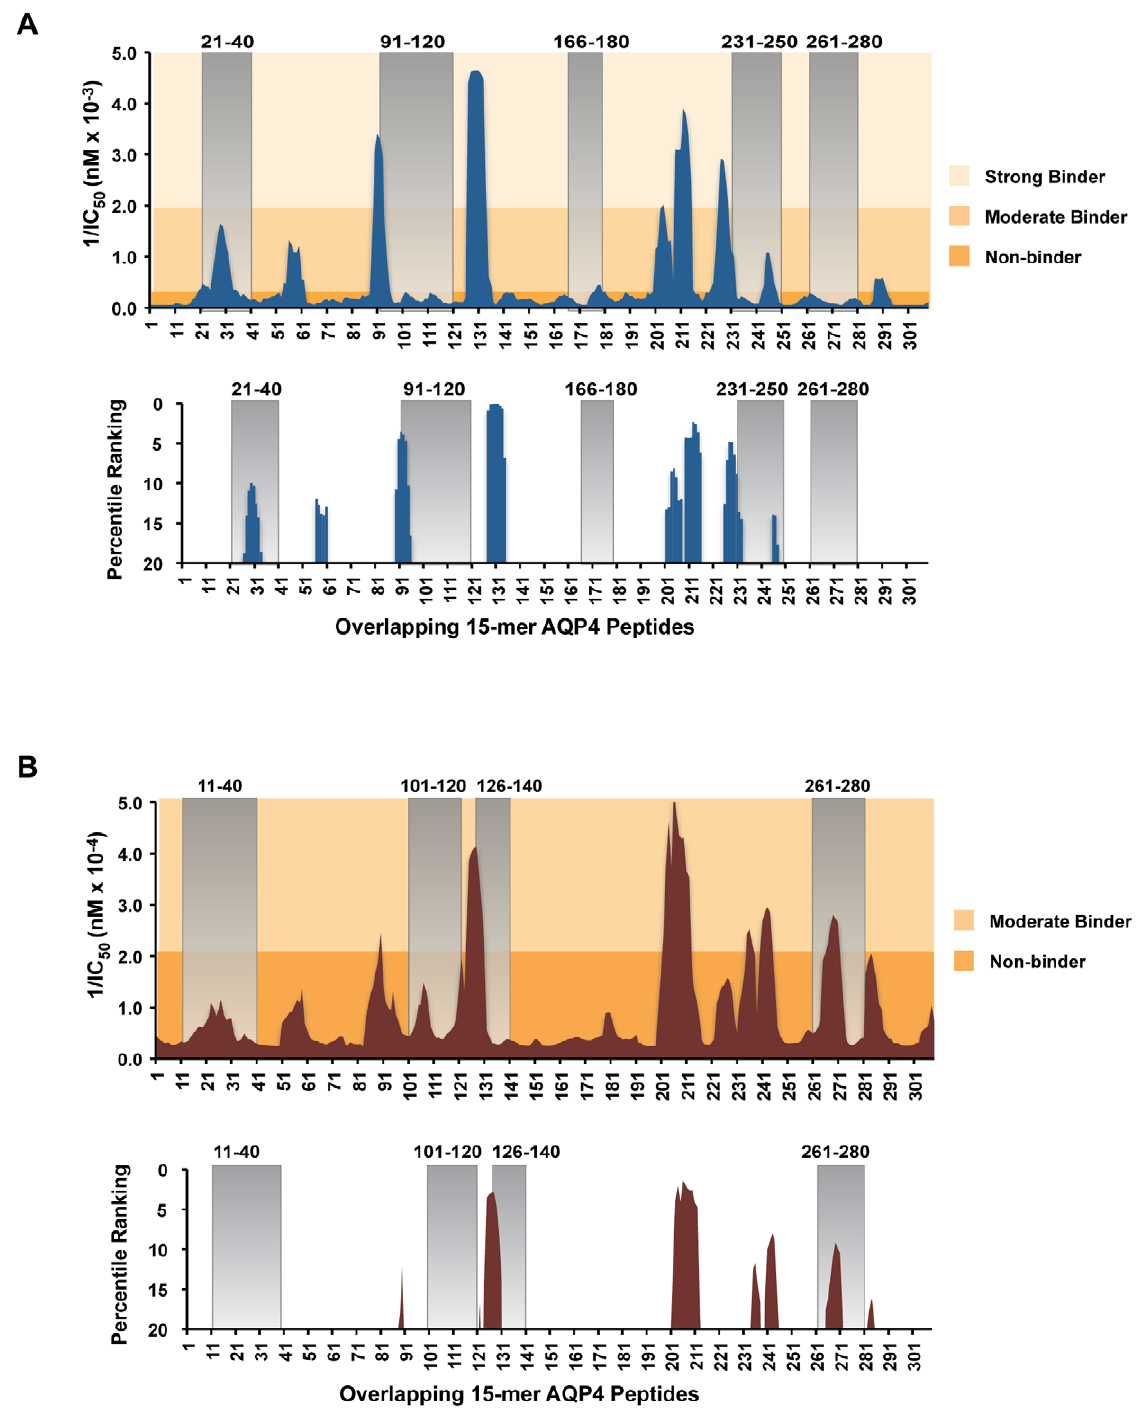
Figure 6. Predicted I-A b - and I-A s - binding mAQP4 epitopes for T cell recognition. MetaSVMp, a quantitative binding affinity program that employs the immune epitope database (IEDB) [26,27,30], was used to identify potential I-A b - and I-A s -binding of AQP4 determinants for T cell recognition. Inverse of 50% inhibition concentration values (1/IC 50 ) is plotted for I-A b (A top panel) and I-A s (B top panel). Peaks correspond to increased predicted binding affinity: strong binding, IC 50 , 500 nM; moderate binding, IC 50 . 500 nM and , 5,000 nM, and non-binding, IC 50 . 5,000 nM. Peaks correspond to increased predicted binding affinity. The top 20% of all possible epitopes are shown for I-A b (A bottom panel) and I-A s (B bottom panel). MetaSVMp percentile ranks were acquired from the MetaMHC web-based application; tall peaks correspond to top- ranked predicted epitopes.